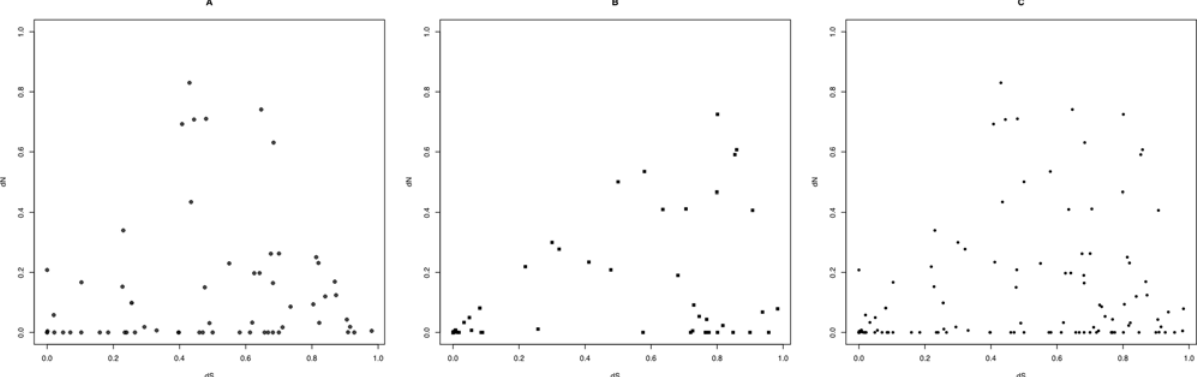
Figure 2. Observed nonsynonymous differences per site (dN) and synonymous differences per site (dS) in pairwise comparisons for three different partitions of genes. A. Putative Virulence factors. B. Randomly selected controls. C. Both groups of genes analyzed altogether.